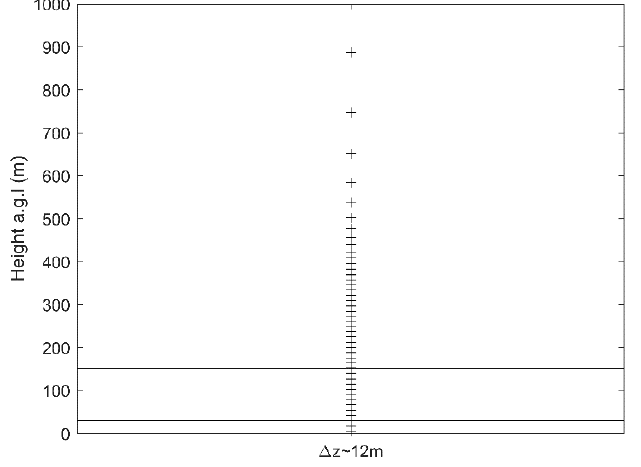
Figure 2. Heights of the vertical levels for the different vertical resolutions. The top and bottom heights of the rotor area of the Siemens SWT-3.6-120 onshore wind turbine model are shown as horizontal lines. Table 2. Descriptions of the main simulations. The red font color indicates the additional simula- tions not involved in the evaluations but providing contributions to the WFP’s components to wind farm wake impacts. The second column is the choice of MYNN scheme, regular MYNN scheme, or EDMF scheme. In the column of TKE advection (TKE adv.), parentheses for enabled TKE advection represent bugged (B) and bug-free (BF) versions. In the next column, CF represents the correction factor for C TKE . In the next two columns, it is shown whether W FP’s TKE and momentum tendency components are disabled. PBL